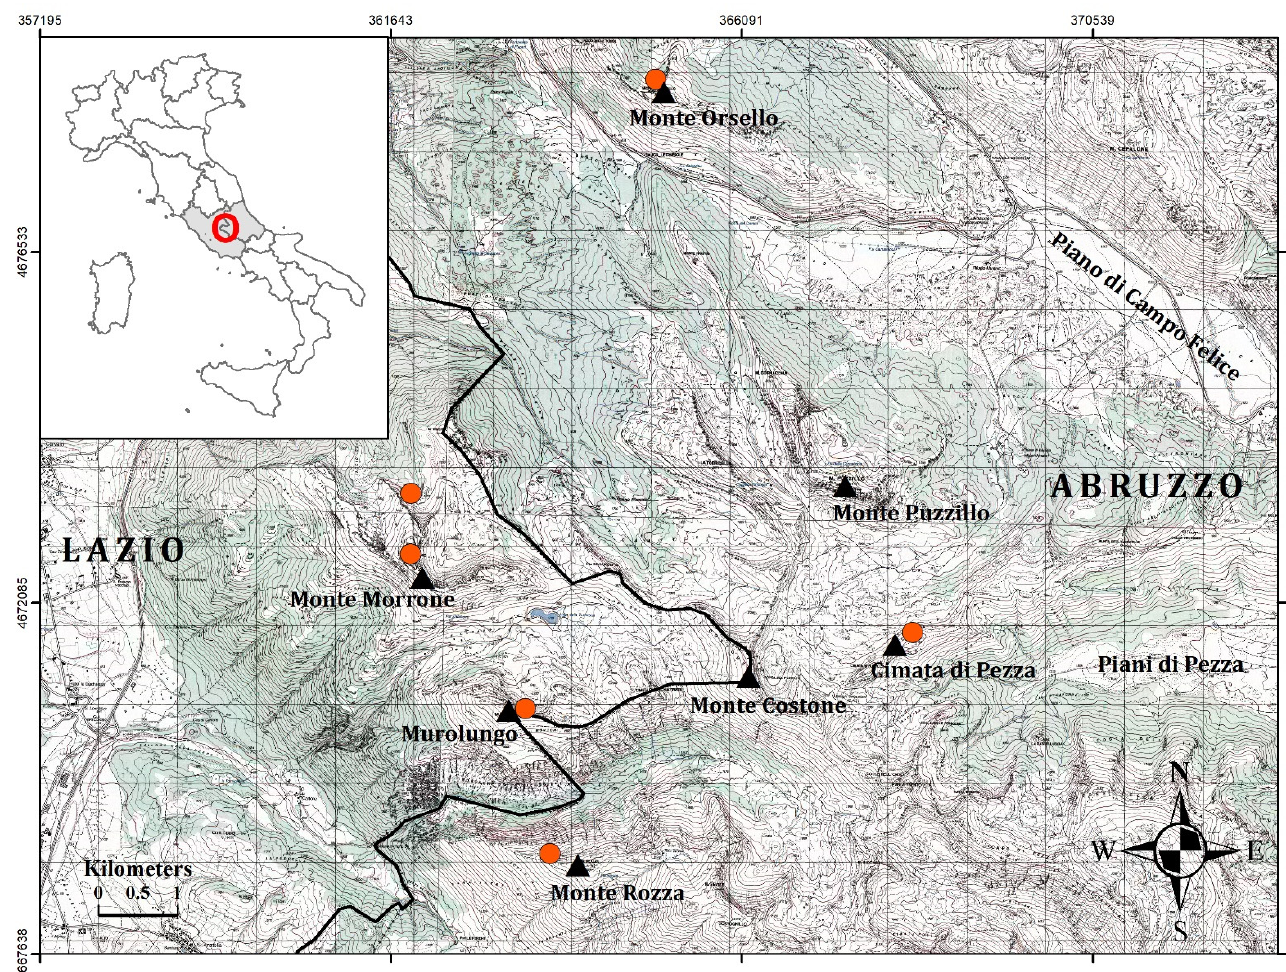
Figure 3. Map showing distribution of Allium ducissae in the Central Apennines, Lazio and Abruzzo, Italy. Latitude and longitude coordinates are expressed in meters using the WGS84 UTM 33N projected coordinate system.